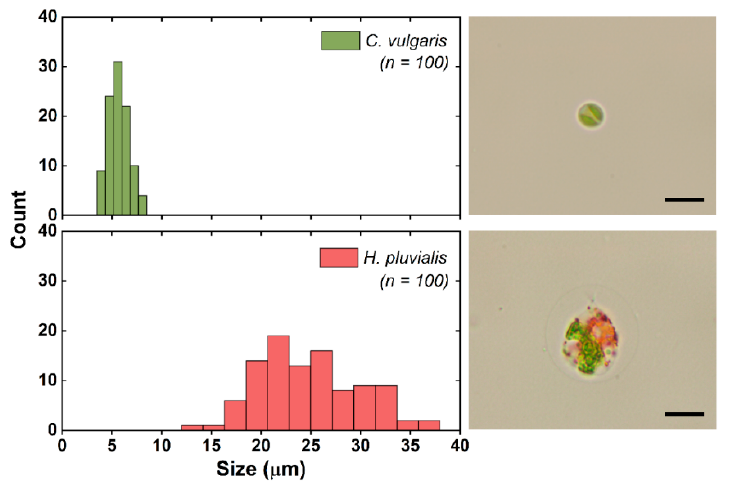
Figure 2. The size distribution of C. vulgaris and H. pluvialis and their respective microscopic im- ages. Scale bar = 10 μ